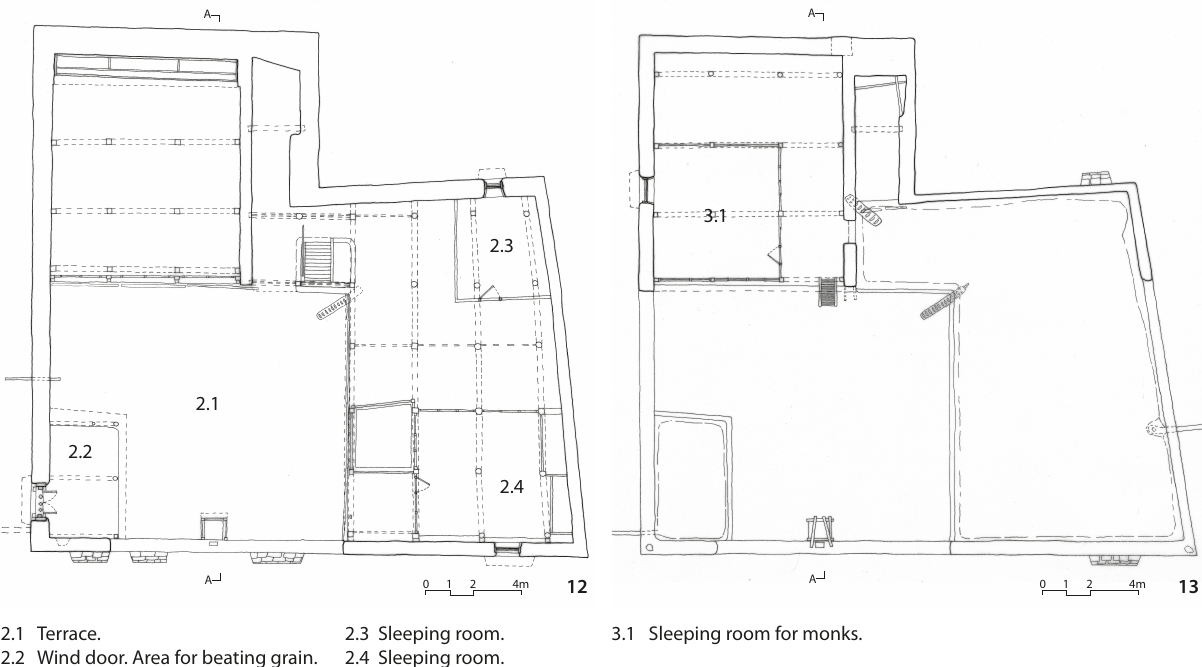
Figure 12 Second floor plan of the farmhouse in Chatreng (Source: the authors).